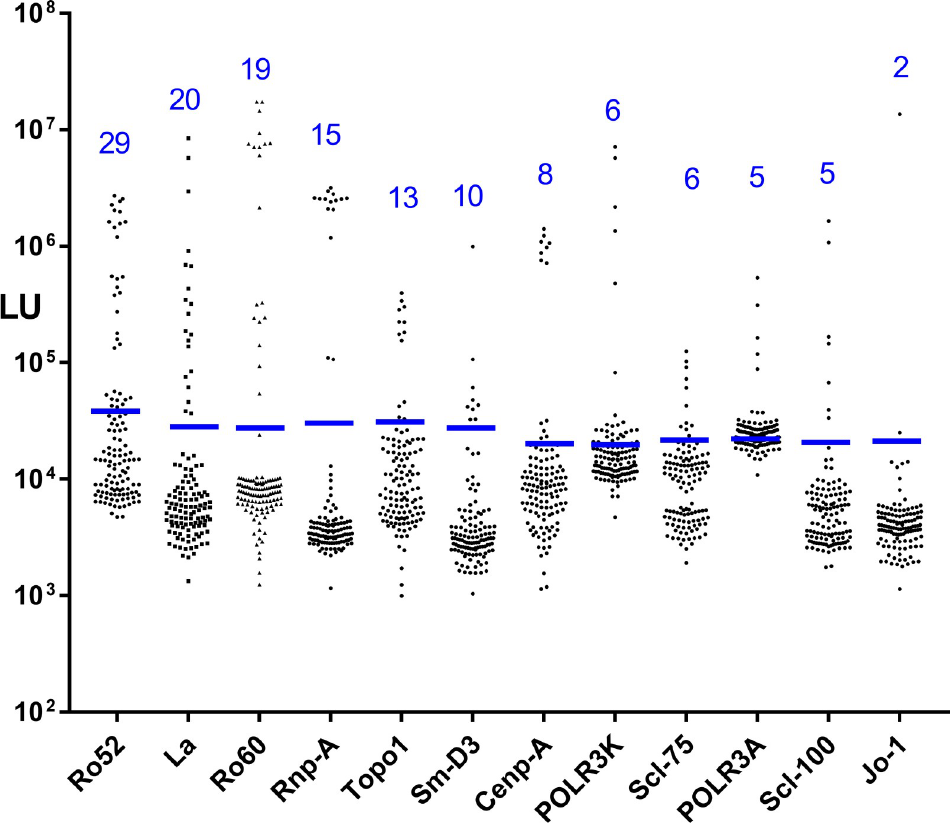
Fig 2. Serum autoantibody levels in the SSc/SRC and SSc/no SRC cohort. Autoantibody measurements were made by LIPS against the 12 autoantigens in the 121 blinded serum samples corresponding to a total of 16 SRC and 30 SSc/no SRC cases. The Y axis reflects the antibody levels in LU determined by LIPS. The blue line is the cut-off value for each antigen. As shown by the numbers in blue, the most prevalent autoantibodies were against Ro52, while the least common were against the Jo-1